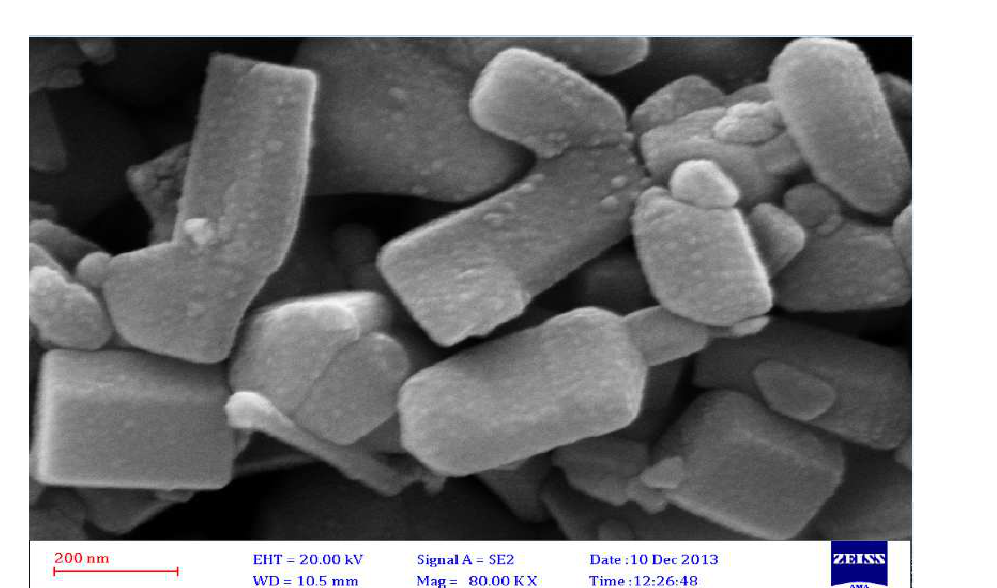
Figure 2. Standard error of the mean image of in situ surface